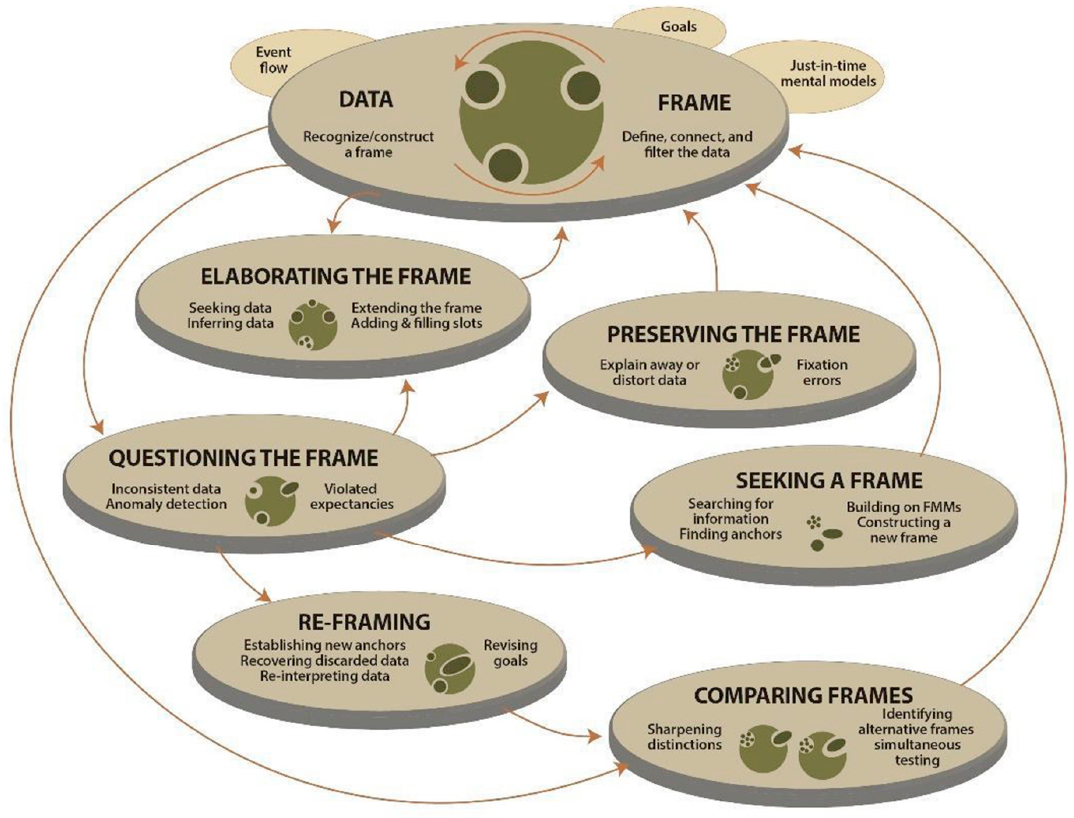
Figure 1. The data-frame theory of sensemaking (adapted from Klein et al. [45]).